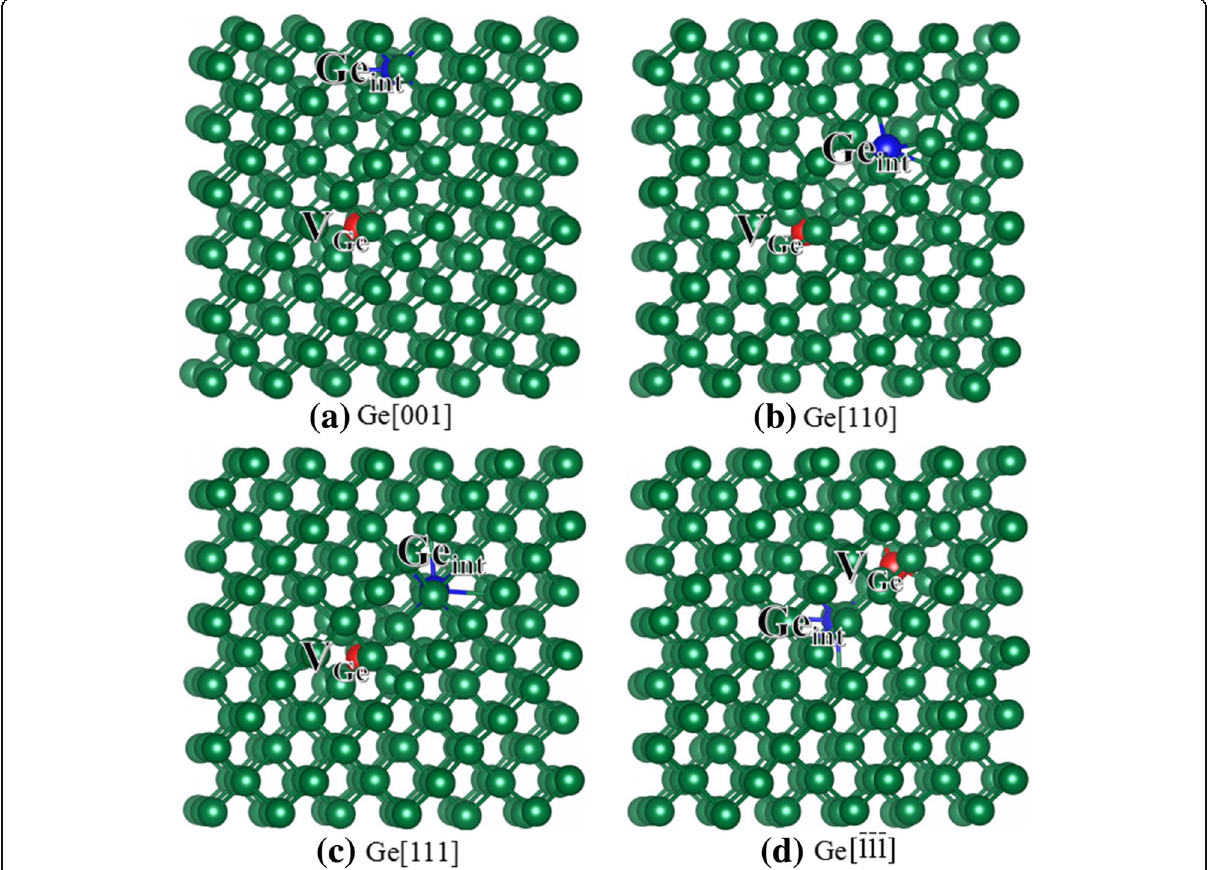
Fig. 3 a – d Schematic view of geometrical structures of damage Ge after recoil events. The red and blue spheres represent the vacancy and interstitial defects, respectively. V Ge : germanium vacancy; Ge int : germanium interstitial